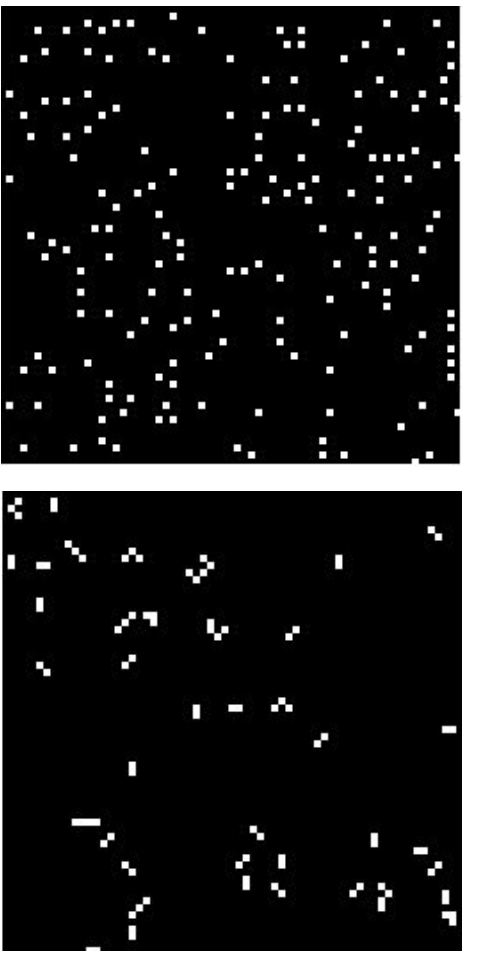
Figure 12. Isolated points extracted (top picture) and remaining small-scale objects (bottom picture) after thresholding of Gaussian noise field